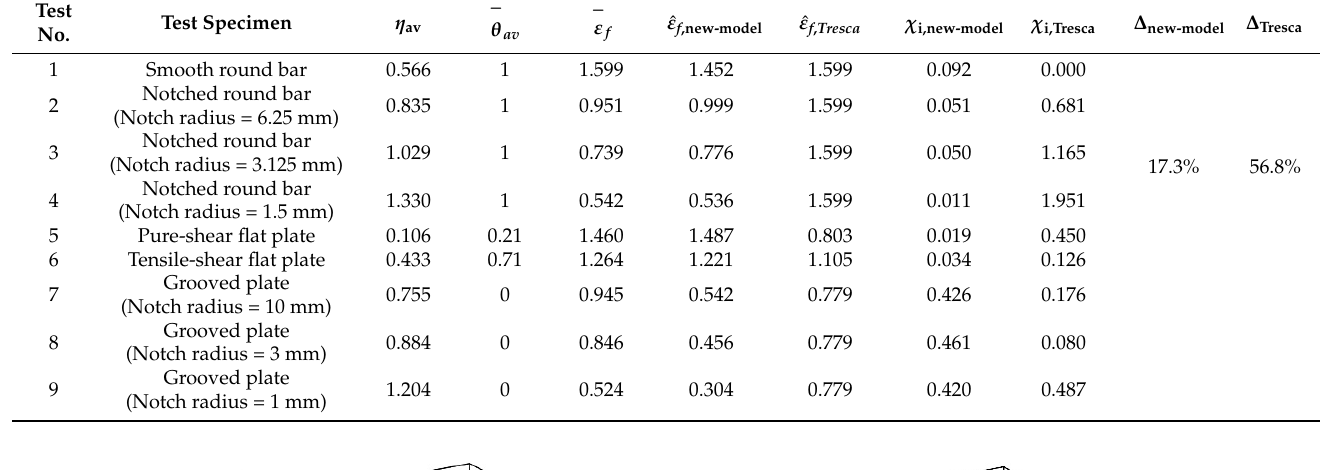
Table 3. Experimental data obtained from the Q460 high-strength structural steel specimens [33].